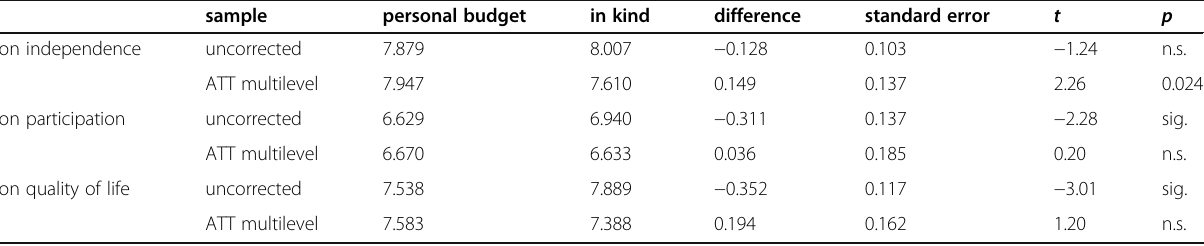
Table 3 Sensitivity analysis, excluding the variable mastery from the propensity score calculation: Estimated values for the dependent variables (on a scale from 1 to 10) independence, participation and quality of life for respondents who have chosen a PB or help in kind ( n =